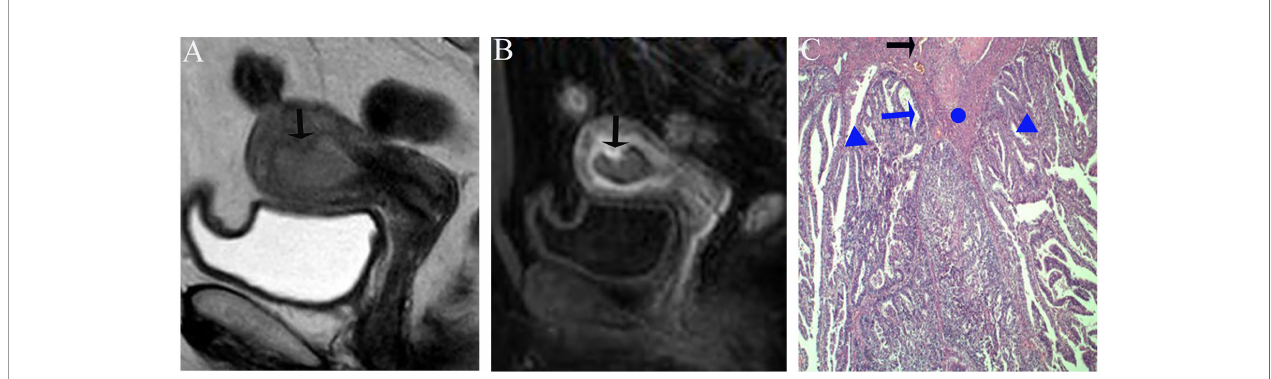
FIGURE 3 | (A) Sagittal-T2WI image, the tumor has moderate signal intensity and is found in the uterine cavity. The focal myometrium protrudes toward the lesion (black arrow). (B) Early (25.1 s) sagittal-DCE image shows the FIPE, a focal irregular enhancement (black arrow). (C) The photomicrograph (HE, 200×) shows the irregular endomyometrial junction (blue arrow) with the dilated vessels (black arrow) of the myometrium (circle). Note the undulating contour and extension of the myometrium between the tumors (triangle). This case was histologically proven to have endometrioid carcinoma, G1 with no myometrial invasion, and was overestimated